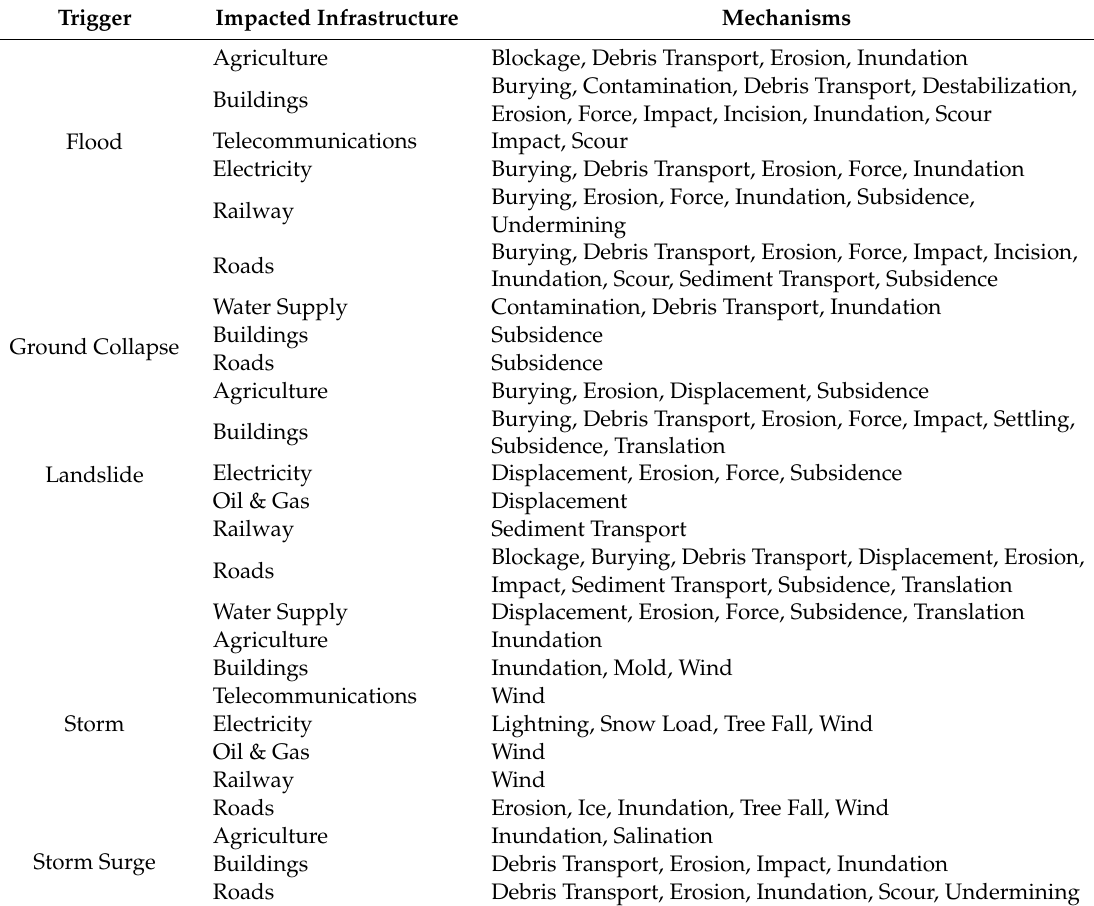
Table 3. Mechanisms by natural hazard trigger and infrastructural impact type.